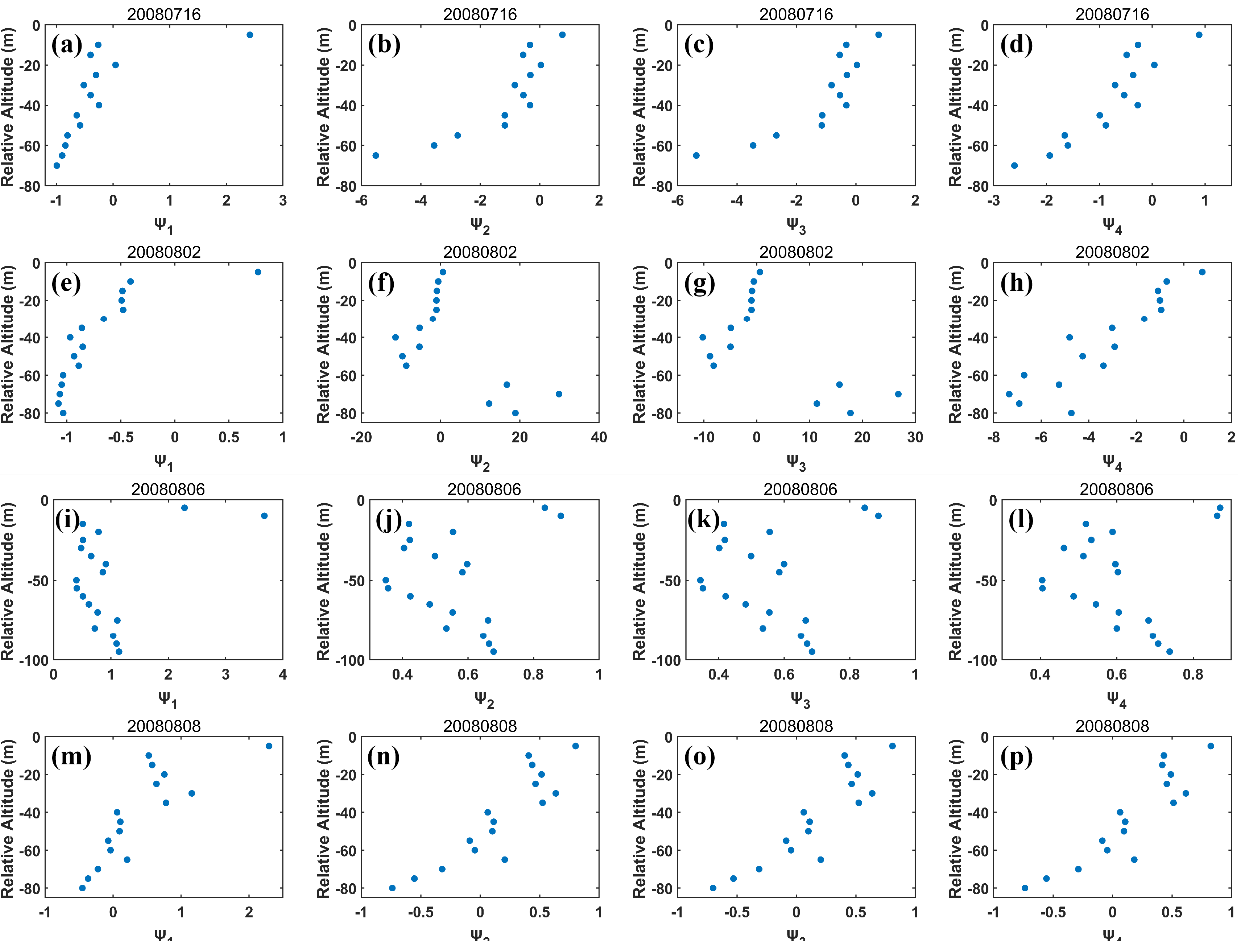
Figure 3. Height dependence of the first homogeneous mixing degree ( ψ 1 ) on (a) 16 July 2008, (e) 2 August 2008, (i) 6 August 2008 and (m) 8 August 2008; height dependence of the second homogeneous mixing degree ( ψ 2 ) on (b) 16 July 2008, (f) 2 August 2008, (j) 6 August 2008 and (n) 8 August 2008; height dependence of the third homogeneous mixing degree ( ψ 3 ) on (c) 16 July 2008, (g) 2 August 2008, (k) 6 August 2008 and (o) 8 August 2008; and the fourth homogeneous mixing degree ( ψ 4 ) on (d) 16 July 2008, (h) 2 August 2008, (l) 6 August 2008 and (p) 8 August 2008. The relative altitude on the y axis equal to 0 represents the cloud tops. Adiabatic liquid water content (LWC a ) is obtained by the adiabatic growth from cloud base, adiabatic number concentration ( n a ) is assumed to be the maximum volume mean radius at each level, and adiabatic volume mean radius ( r va ) is calculated with LWC a and r va